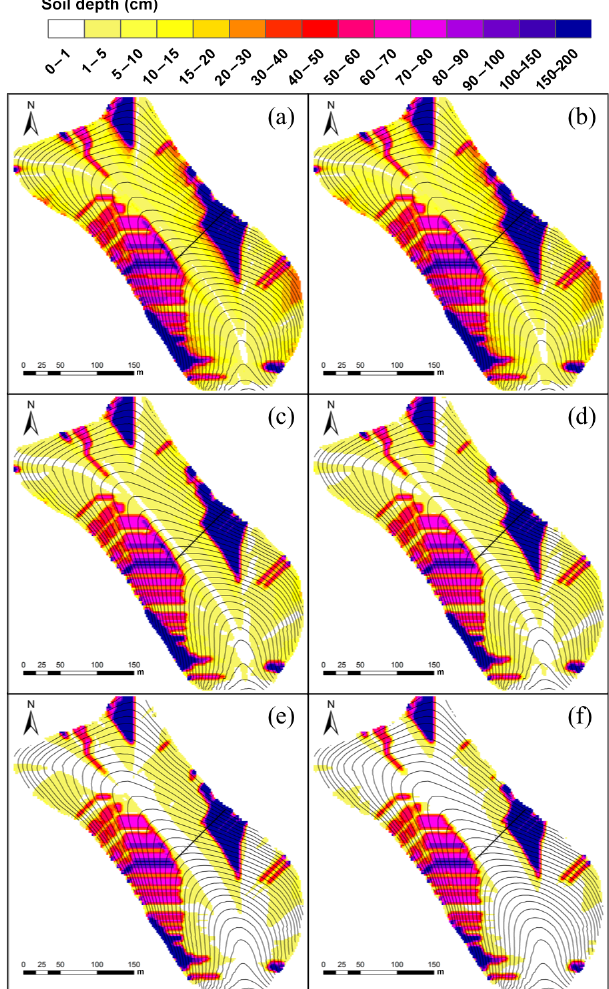
Figure 5. Soil depth maps produced by the diffusive-only simu- lation (S2) at 3.2kyr time intervals in the last 18 of 80kyr sim- ulated: (a) 18kyrBP, (b) 12.8kyrBP (end of P1), (c) 9.6kyrBP, (d) 6.4kyrBP (end of P2), (e) 3.2kyrBP, and (f) 0kyrBP (fi- nal/modern end of P3). The contour lines represent 2m change in